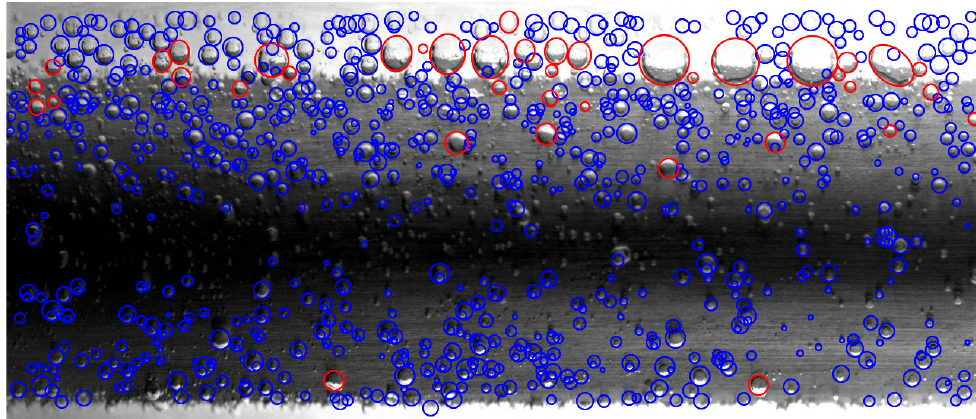
Figure 7. Image processed by a neural network. Automatically detected bubbles are shown in blue while manually added bubbles are shown in red. Reprint with permission [20].